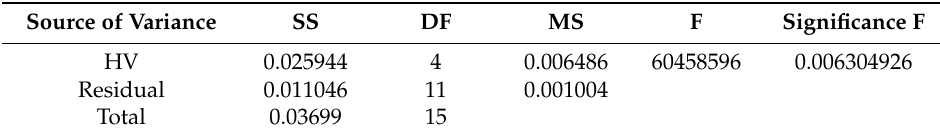
Table 9. Variance analysis of surface hardness